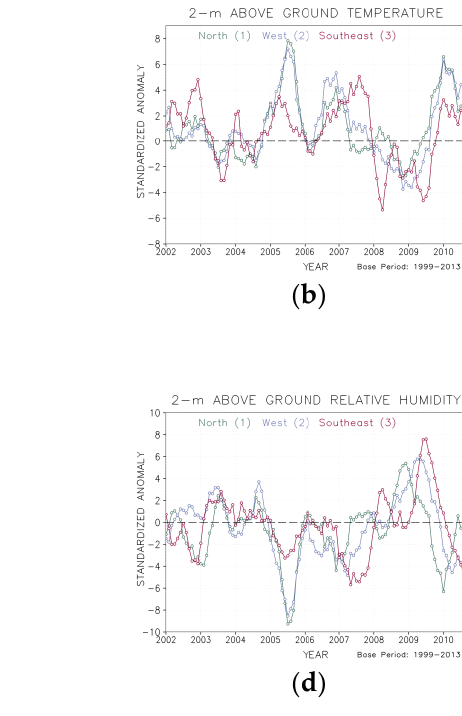
Figure 3. The standardized anomaly of: ( a ) precipitation; ( b ) temperature at 2-m above ground; ( c ) vertically integrated soil moisture; ( d ) relative humidity at 2-m above the ground as modeled by SRDAS. Monthly means are averaged over the following regions: north (area 1, green curve), west (area 2, blue curve), and southeast (area 3, red curve) in the Amazon basin, as delimited in Figure 1. Monthly mean and standard deviation calculated over the base period 1999 – 2013.